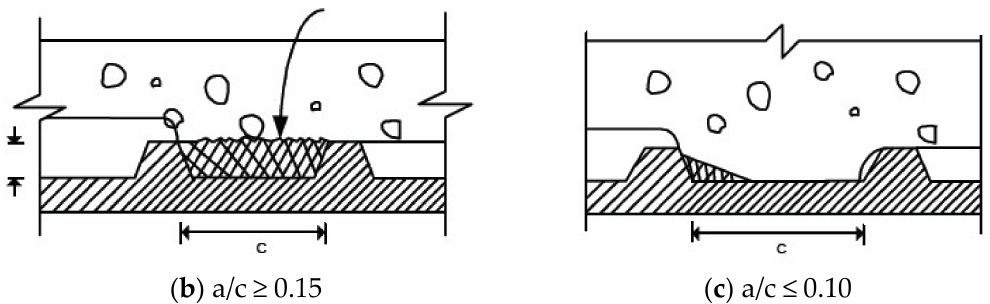
Figure 13. Adhesive fracture depending on the rib geometry of the deformed reinforcing bars [57].